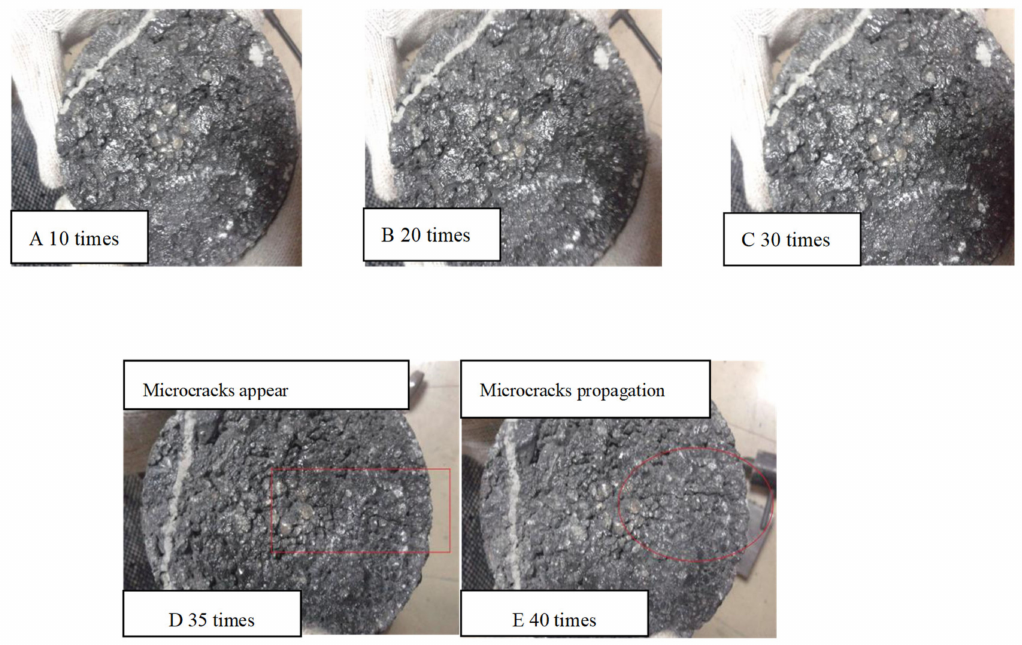
Figure 3. Cracking phenomenon of UTL under di ff erent impact times: ( A ) Impact 10 times; ( B ) Impact